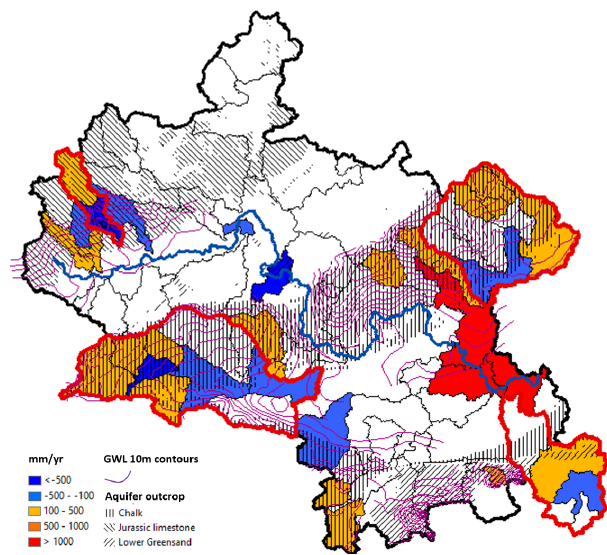
Figure 5. Annual average reach water balance metrics for the Thames at Kingston from 1994–2014 inclusive, showing unac- counted for annual water volume from precipitation after subtrac- tion of actual evaporation and naturalised river flow (in millimetres per year), in relation to aquifer outcrop areas and median ground- water level contours for the same time period. A reach where the water balance residual is within 100mm of balanced is considered to be conservative, to nominally account for data uncertainties (see Sect. 6.3.1). Catchments referred to in the text are outlined in